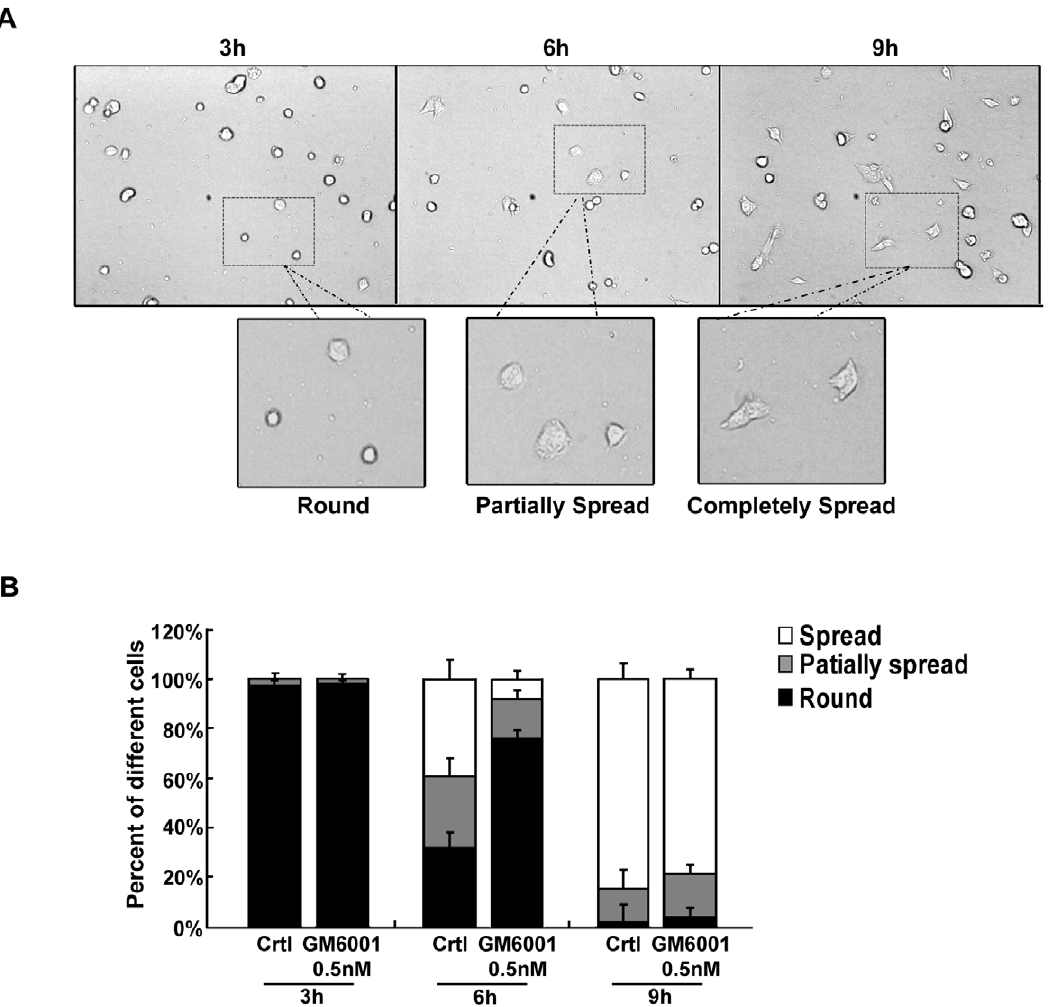
Figure 4. MMP-2 activity affects the spreading of human A375 melanoma cells. (A) The morphology of A375 cell spreading at different time points were designated as round, partially spread and completely spread. (B) Cells were seeded onto coverslips coated with fibronectin, treated with MMP-2I at the concentrations of 0.5 nM at different time points after seeding, and assessed under the microscope. The cells without MMP-2I were defined as control. The differences of cell morphology at 3 h, 6 h and 9 h after seeding were observed and counted (n $ 400).